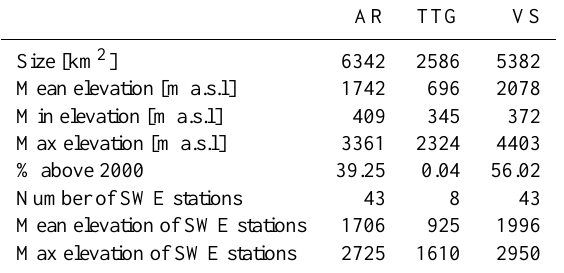
Table 1. Characteristics of the three regions Alpine Rhine (AR), Valais (VS) and Thur/Töss/Glatt (TTG) and the distribution of SWE stations within these